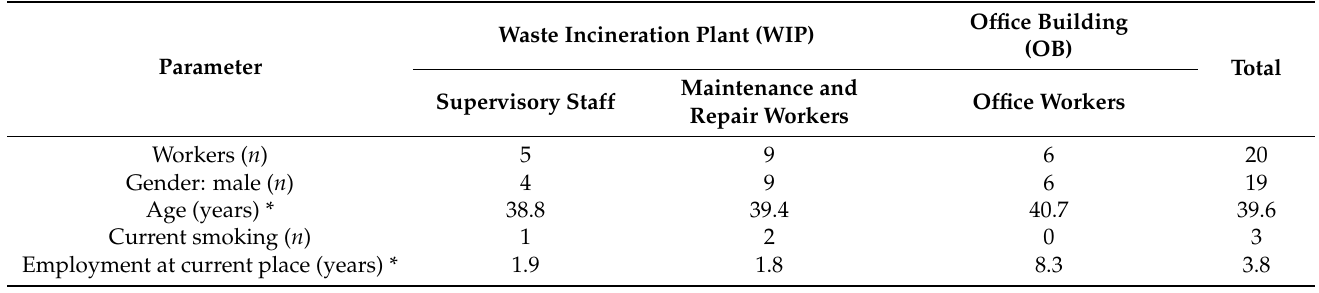
Table 1. Study population